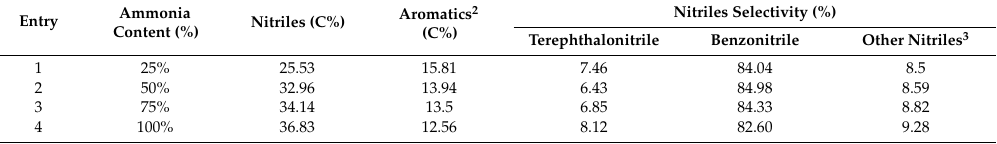
Figure 3. Effect of Ca(OH) 2 loading on Ca(OH )2 -Al 2 O 3 catalysts on ( a ) overall yield and ( b ) nitriles selectivity for selectively producing terephthalonitrile via the catalytic fast pyrolysis of PET with ammonia at 650 °C. (1 g catalyst; N 2 and NH 3 flow rate, 80 mL/min; PET feeding, 0.5 g/batch) Table 4. E ff ect of ammonia content in the carrier gas on selectively producing benzonitrile. 1.